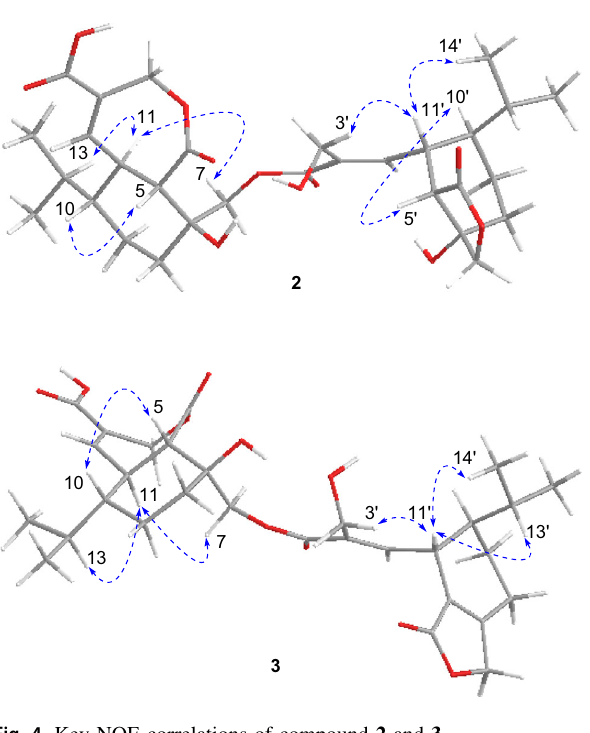
Fig. 4 Key NOE correlations of compound 2 and 3